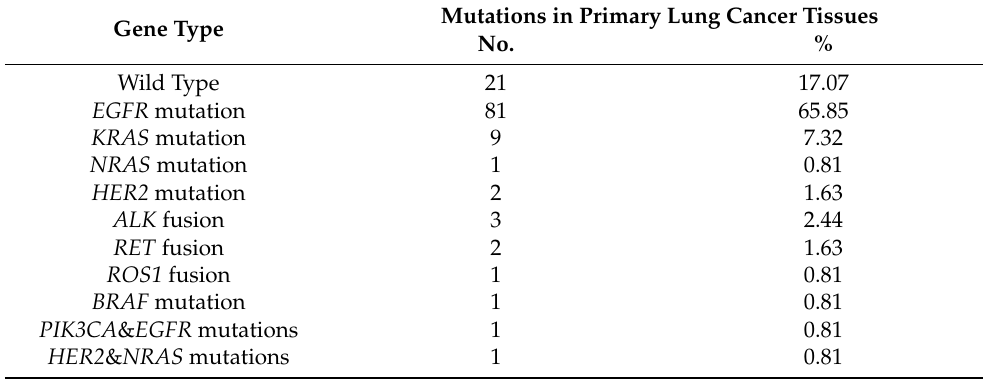
Table 2. Oncogenic gene alterations status in primary lung cancer tissues from 123